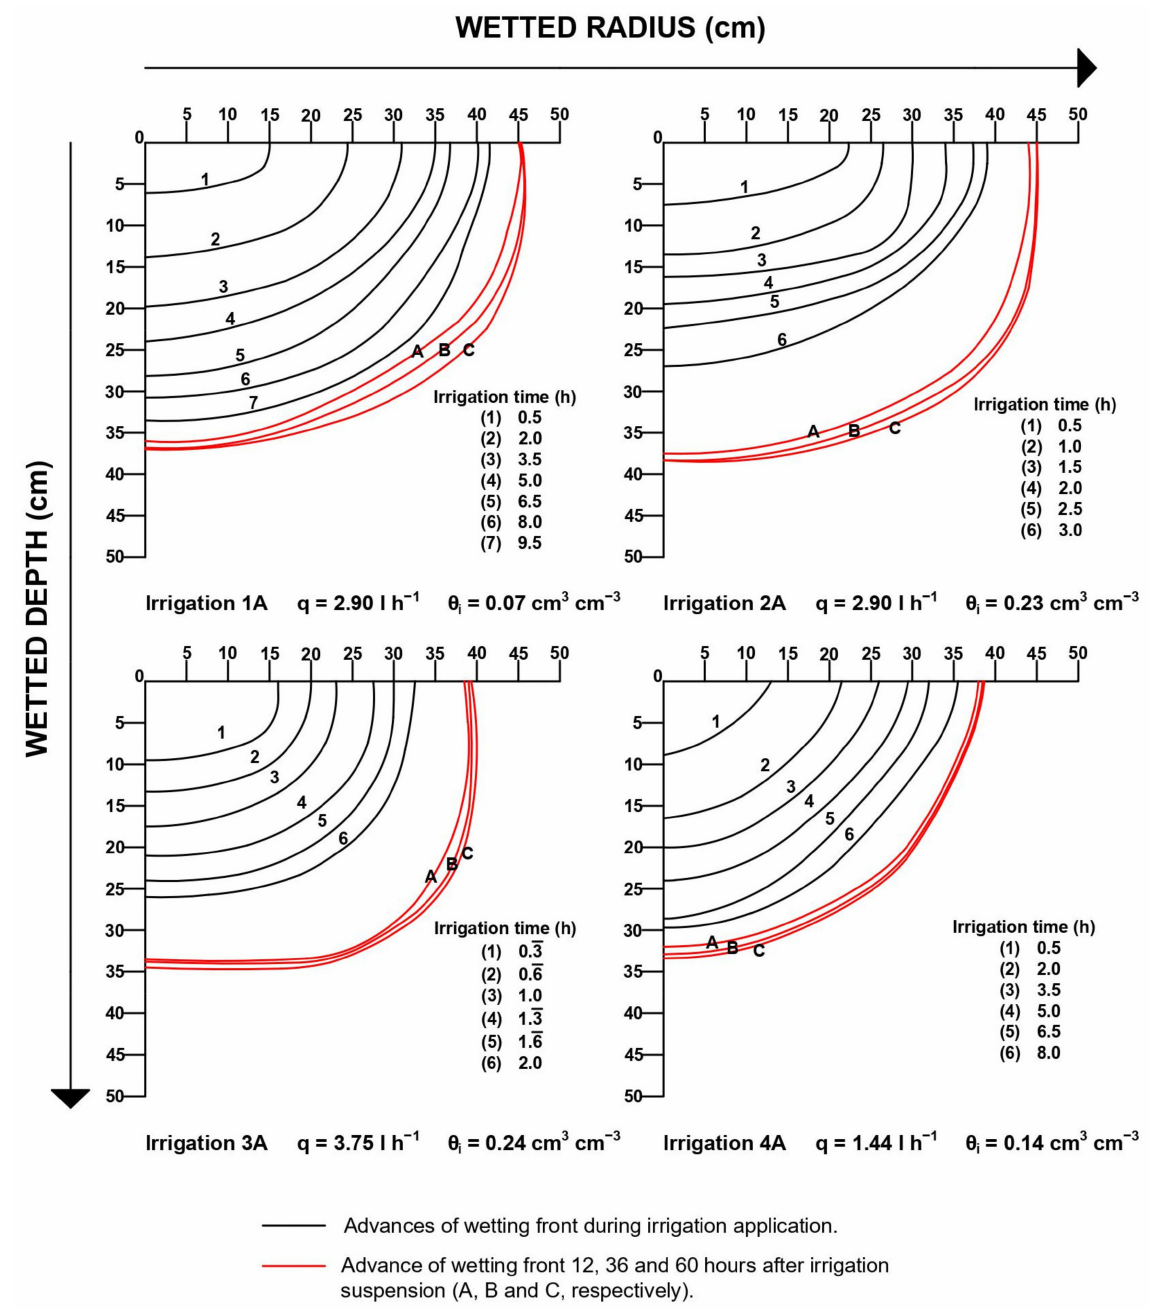
Figure 4. Geometry of the wetting front as a function of irrigation time in the first irrigation